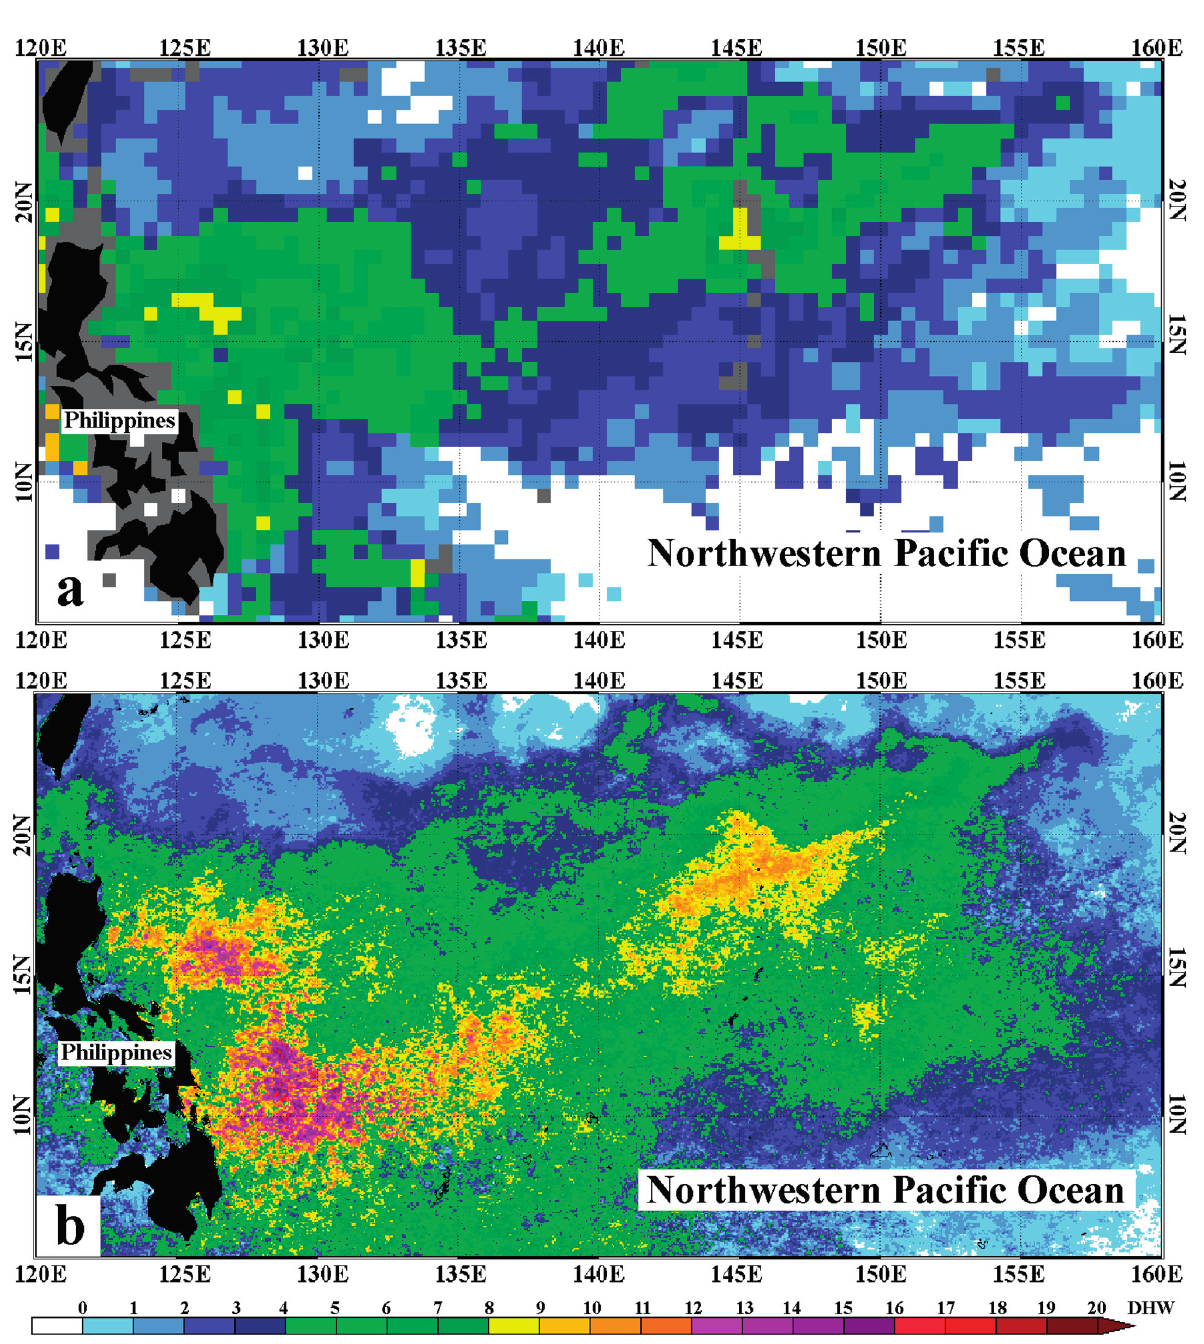
Figure 7. Comparison of NOAA CRW’s ( a ) twice-weekly 50-km DHW product and ( b ) daily 5-km DHW product for 21 July 2014, showing accumulated bleaching thermal stress from 29 April to 21 July (Dark grey pixels in the 50-km images are land